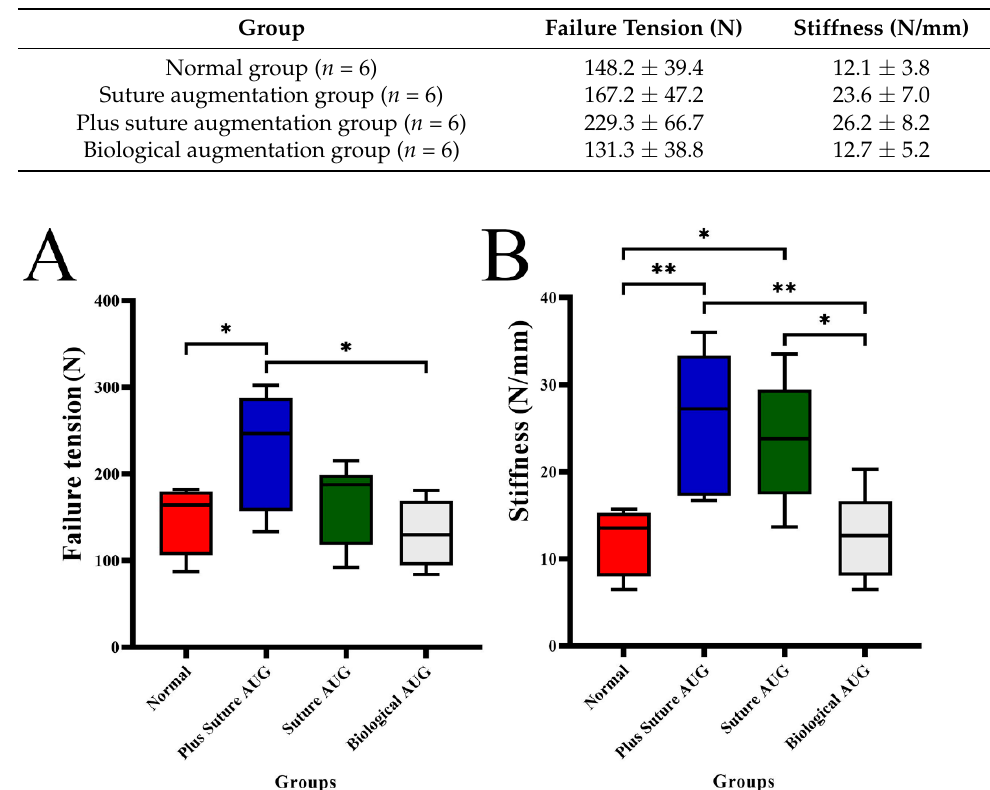
Table 1. Comparison of failure tension and stiffness of three groups of ankle specimens.